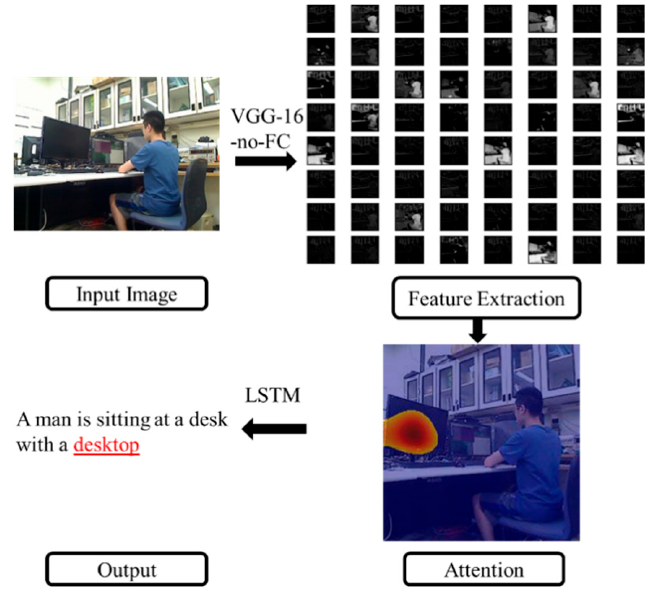
Figure 12. Overview of the image captioning process.